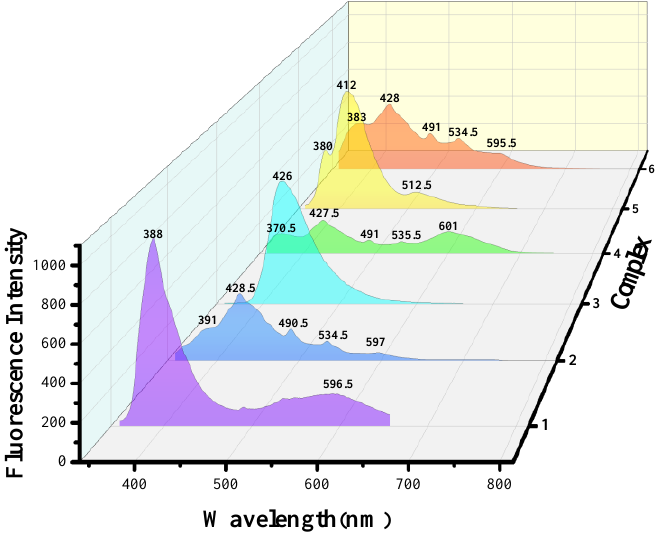
Figure 2. Solid state emission spectra (excitation at 300 nm) of complexes 1 – 6 at room temperature.